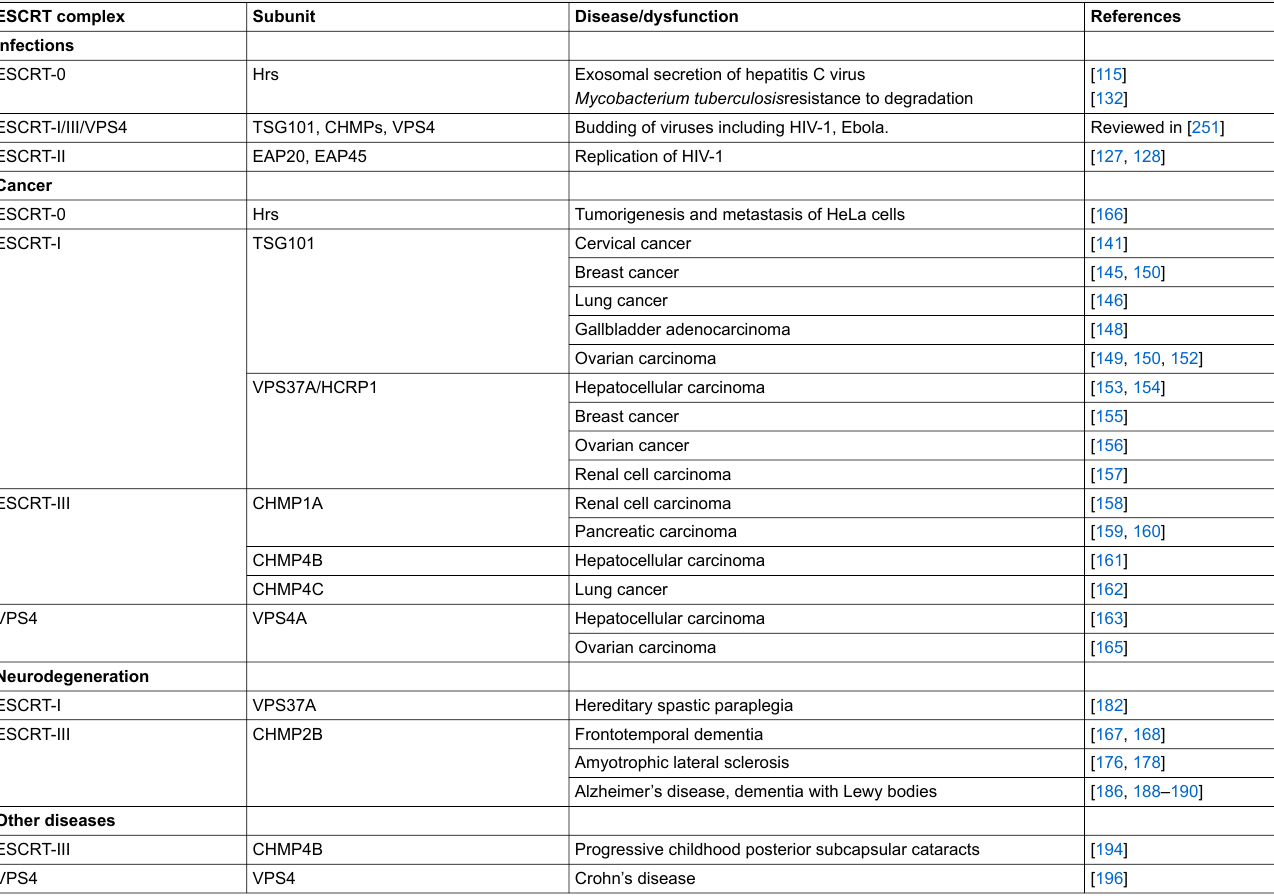
Table 2: Involvement of ESCRT (endosomal sorting complexes required for transport) components in disease. ESCRT complex